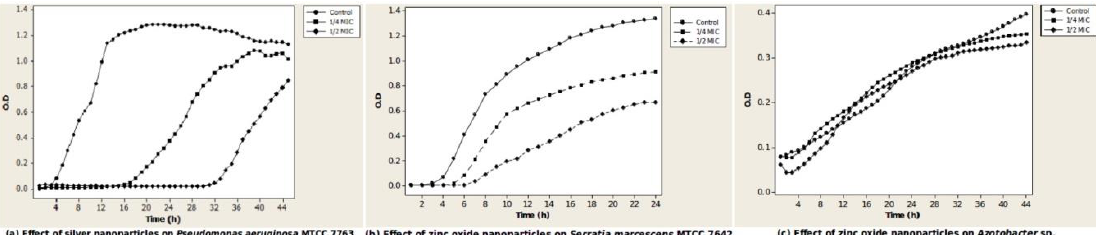
Figure 1. Effect of silver and zinc oxide nanoparticles on growth of pure cultures. The graphs show growth curves of isolates in the presence and absence of nanoparticles. The isolates were inoculated in broth and optical density (OD) recorded every hour for 24–48 h. ( a ) Effect of silver nanoparticles on growth of Pseudomonas aeruginosa MTCC 7763; ( b ) Effect of zinc oxide nanoparticles on growth of Serratia marcescens MTCC 7642; ( c ) Effect of zinc oxide nanoparticles on Azotobacter chroococcum clsxc_A_FLNF. Each point represents mean of triplicate values of absorbance adjusted against data from sterile controls. All growth curve experiments were repeated at least thrice. MIC: Minimum Inhibitory Concentration.